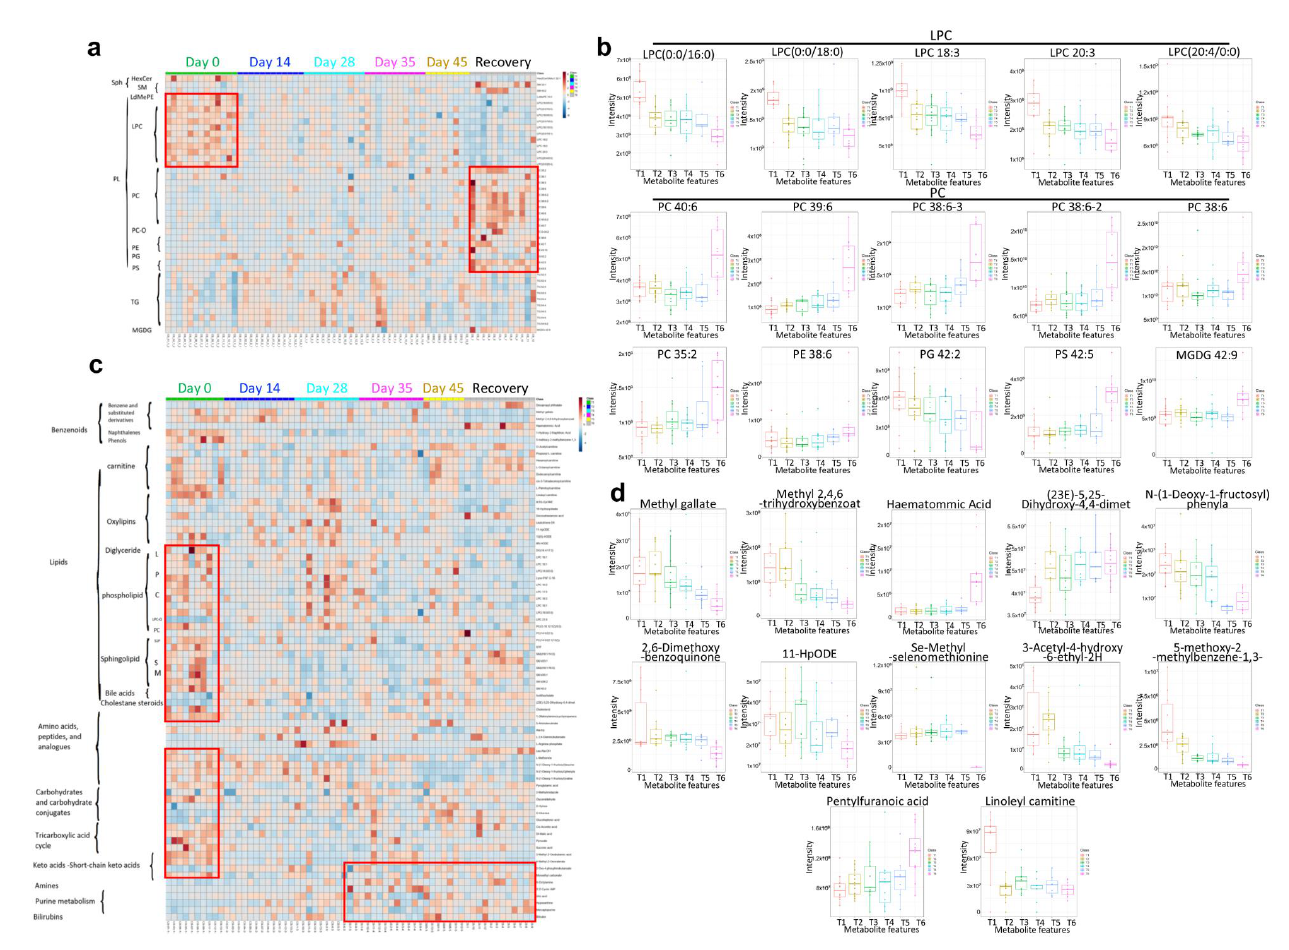
Figure 7. Human plasma lipidomics and metabolomics of vaccination-related or COVID-19-recovered samples and correlated analysis. ( a , b ) Heatmap. ( c , d ) Boxplot. T1 = Day 0, T2 = Day 14, T3 = Day 28, T4 = Day 35, T5 = Day 45, and T6 =